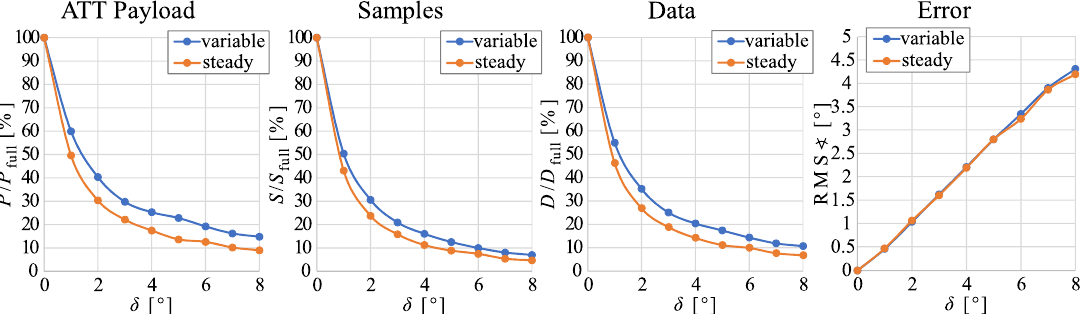
Figure 9. Performance impact comparison of different estimation error thresholds δ on hierarchical ETL. Data from feet-mounted sensors during 4 min of variable gait and steady walking is considered, respectively. The charts show the number P of transmitted data bits, i.e., the size of the ATT Payload, the number S of sampling instants with data transmission, and the total number D of transmitted bits including the Bluetooth 5 overhead with respect to full communication with the values P full , S full , and D full . In addition, the RMS-value of the angle difference between the measured and the estimated body segment orientation is